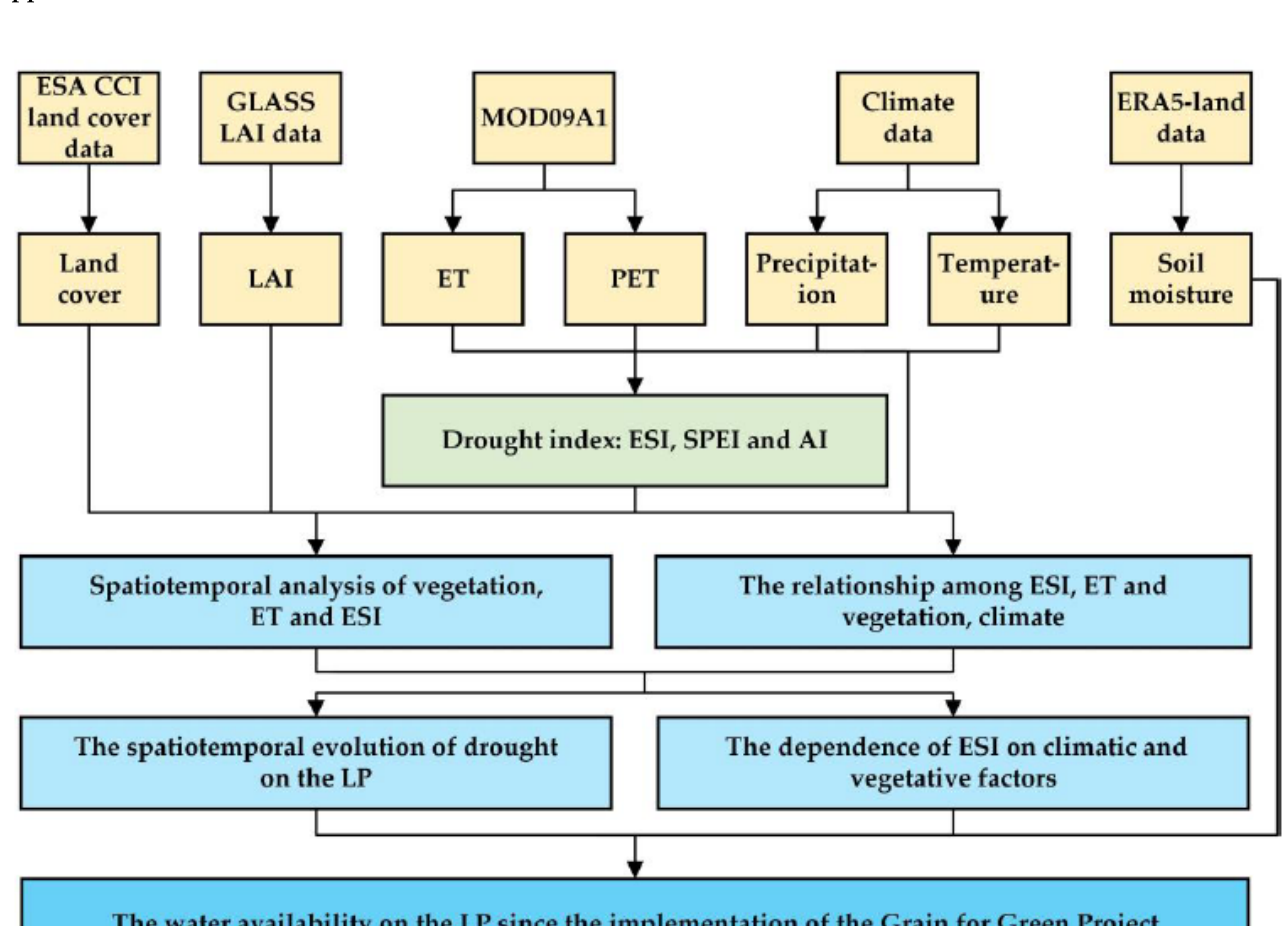
Figure A1. Overview of the methods used in this study.